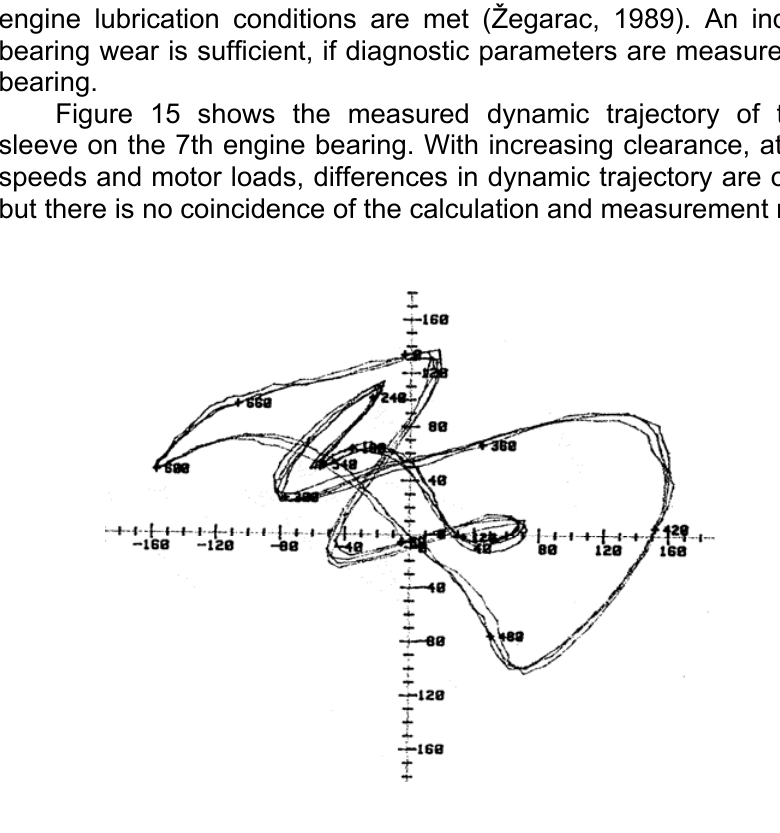
Figure 15 – Dynamic trajectory of the main sleeve on the seventh bearing of the engine crankshaft, engine load 100%, bearing clearance Z = 144  m, rotation speed n = 720 min